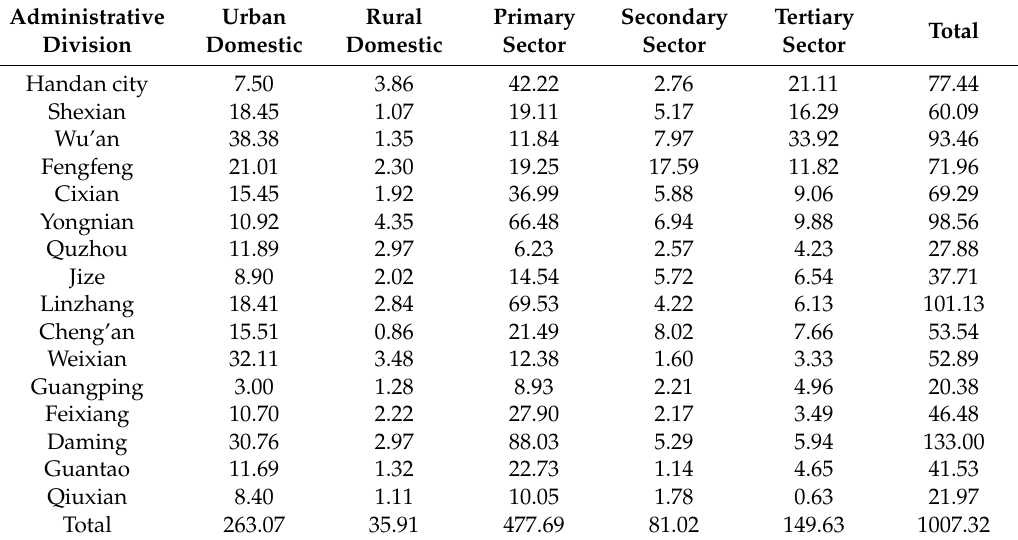
Table 6. Results for groundwater allocated to every user (10 6 m 3